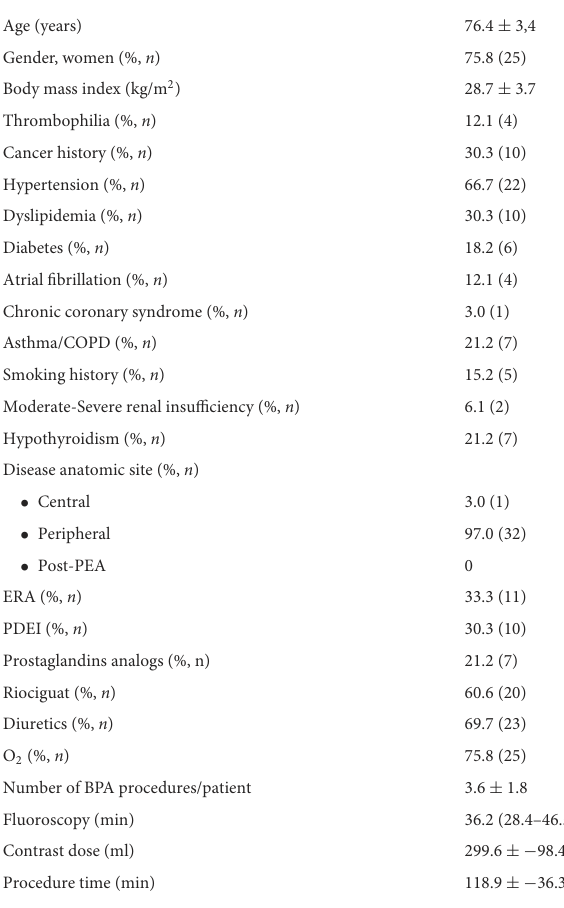
TABLE 2 Baseline demographic characteristics and procedural data ( n =